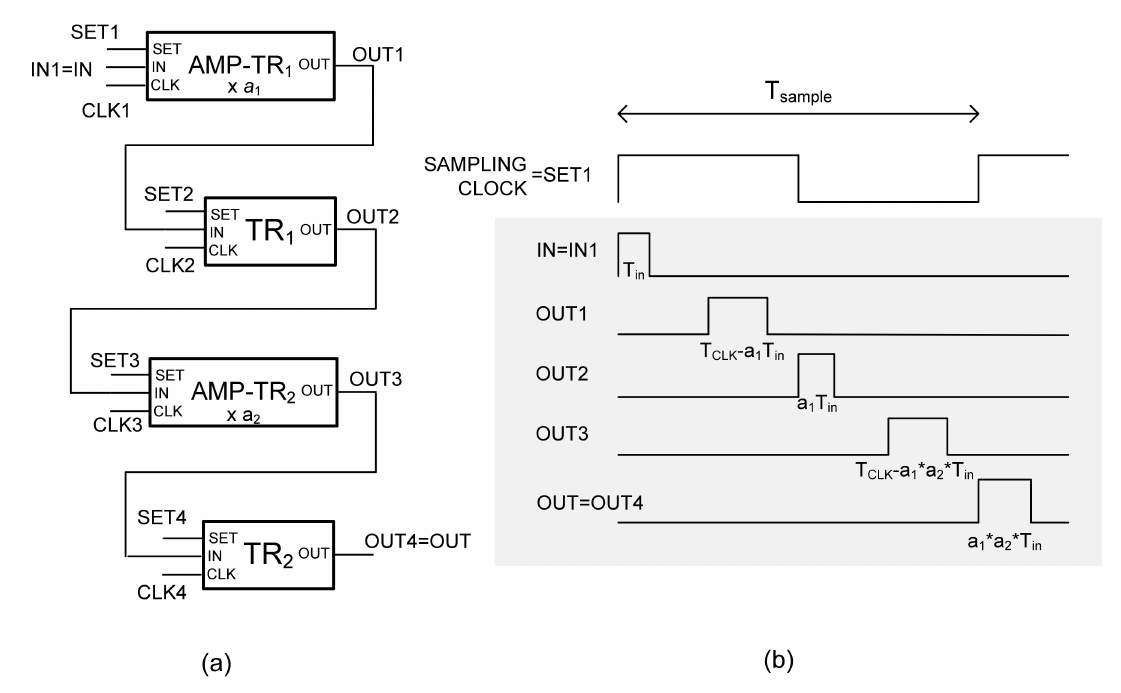
Figure 7. ( a ) Time-mode z − 1 multiplier circuit, ( b ) pulses timing